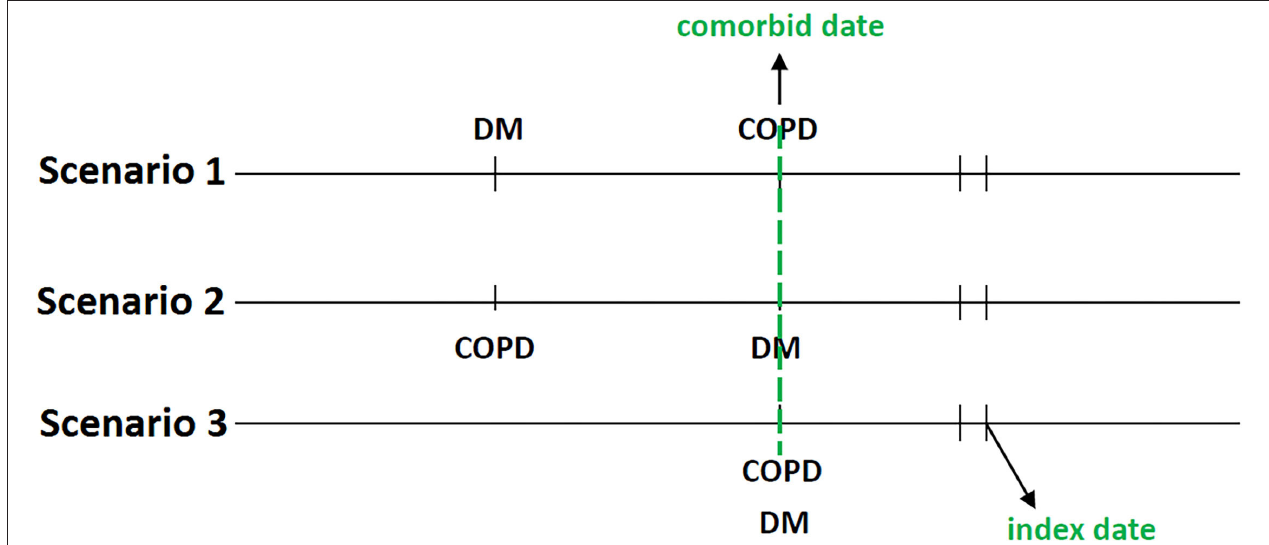
FIGURE 3 | The concurrent diagnosis of T2DM and COPD was defined as the comorbid date. The first date of TZD use after the comorbid date was the index date.